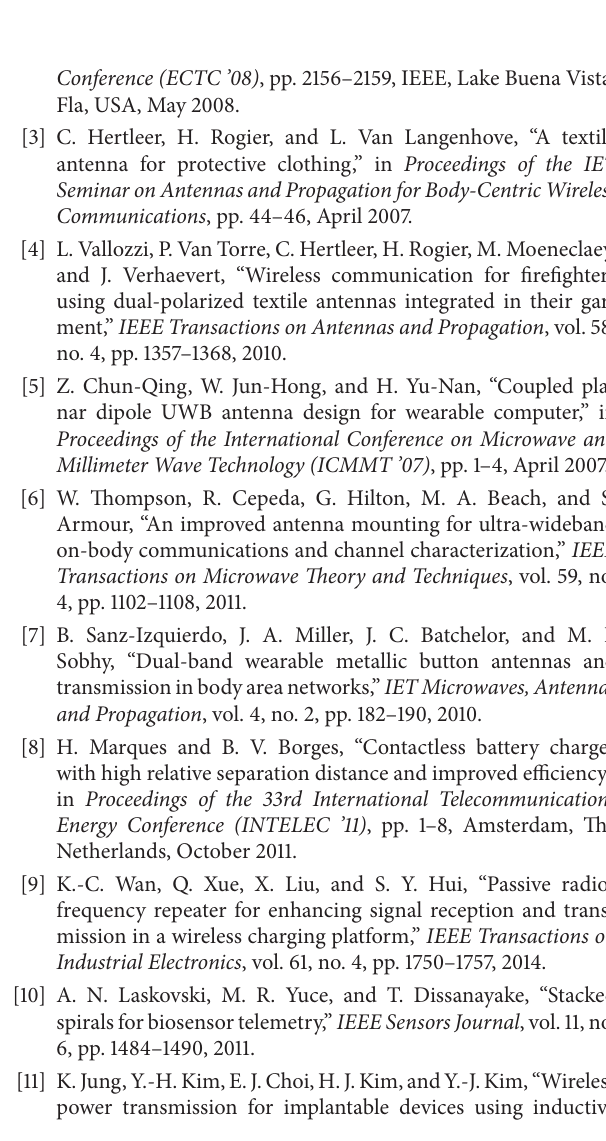
Figure 14: Experimental results obtained for the proposed wireless battery charger: (a) total efficiency as function of the input power ( 𝑃 at the primary resonator (see Figure 1); (b) charging time necessary to recharge the battery THINERGY MEC201 as function of input power ) at the primary resonator (see Figure ( 𝑃 RF-IN